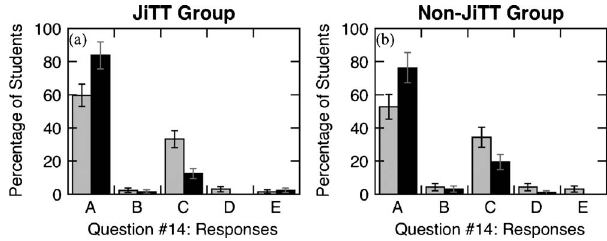
FIG. 6. Student responses to FCI question no. 14 on the pretest (cid:1) gray (cid:2) and post-test (cid:1) black (cid:2) . The correct response is A and the dis- tractor is C. (cid:1) a (cid:2) JiTT and (cid:1) b (cid:2)